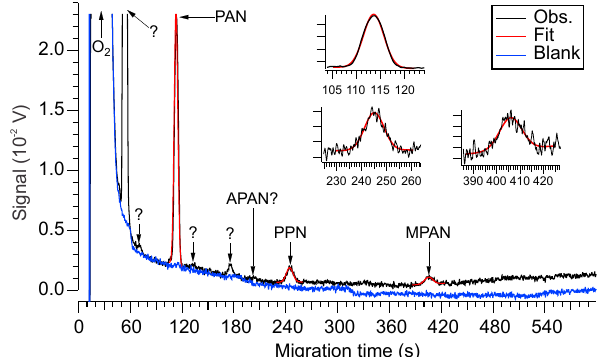
The (slope) accuracy of the FOSSILS data is limited by the accuracy of the calibration, as the peak fitting procedure produces a (comparatively) small and hence negligible error. For PAN and PPN in particular, the limiting factor was the accuracy of the TD-CRDS, which is ± 4 % (Paul and Osthoff, 2010). The accuracy of the MPAN and APAN data is conser- vatively estimated at ± 15 and ± 25 %, respectively, because of the large uncertainties in calibration standard